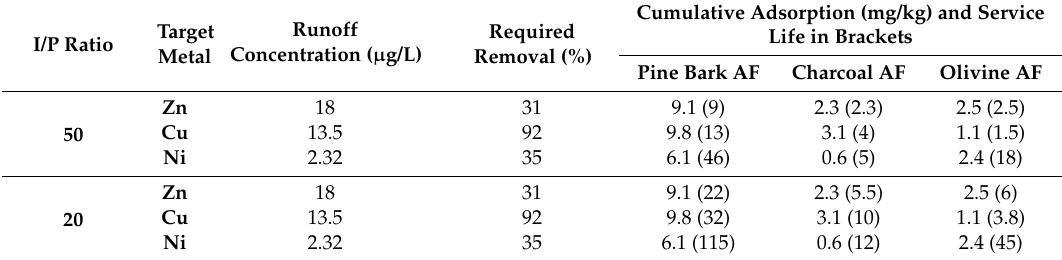
Table 7. Cumulative adsorption at the required removal and service life in (years) for different filters with respect to the target metals. I/P stands for impervious area to pervious area ratio and AF for amended